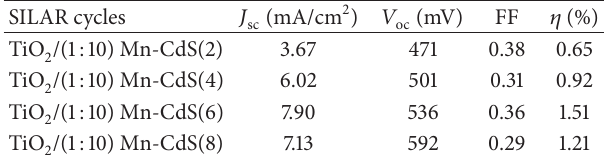
Table 3: Different photovoltaic parameters for different